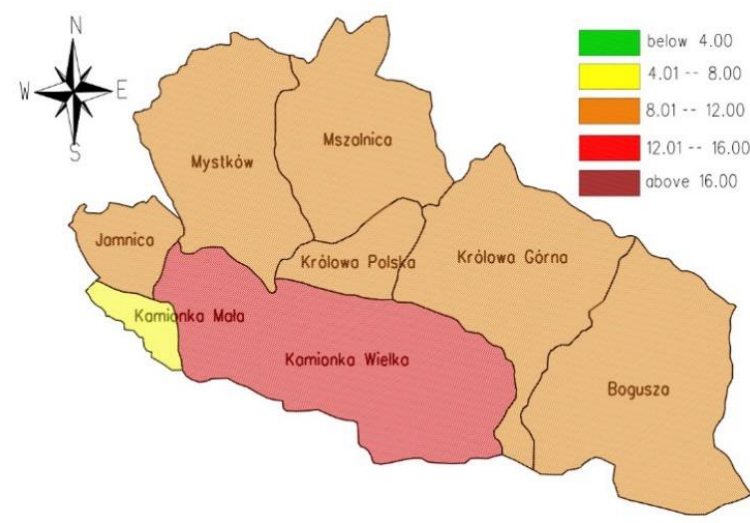
Figure 4. WIT 2 - non-agricultural activities for the municipality Kamionka Wielka. Figure 4. WIT 2—non-agricultural activities for the municipality Kamionka Wielka.